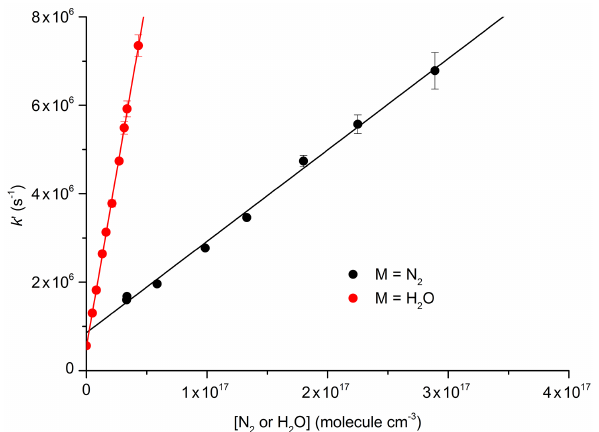
Figure 7. Plot of primary OH and expected OH (solid lines af- + H ter 8.28ms) from NO ∗ 2 O at various values (0% to 10%) of 3 k 12 b /k 12 . The initial OH concentration (right y axis) was 2 . 0 × 10 12 moleculecm − 3 . The dashed red line displays the calculated NO 3 concentration, which at 8.28ms (time of 662nm excitation pulse) was 9 × 10 11 moleculecm − 3 . In these conditions 50% of available NO 3 was excited to NO ∗ by absorption at 662nm; 35% 3 of this NO ∗ proceeded to react with H 2 O in Reaction (R12), with 3 the balance quenched by N 2 or HNO 3 . The solid lines ( t > 8 . 28ms) represent expected OH signals for values of k 12 b / k 12 between 0% and